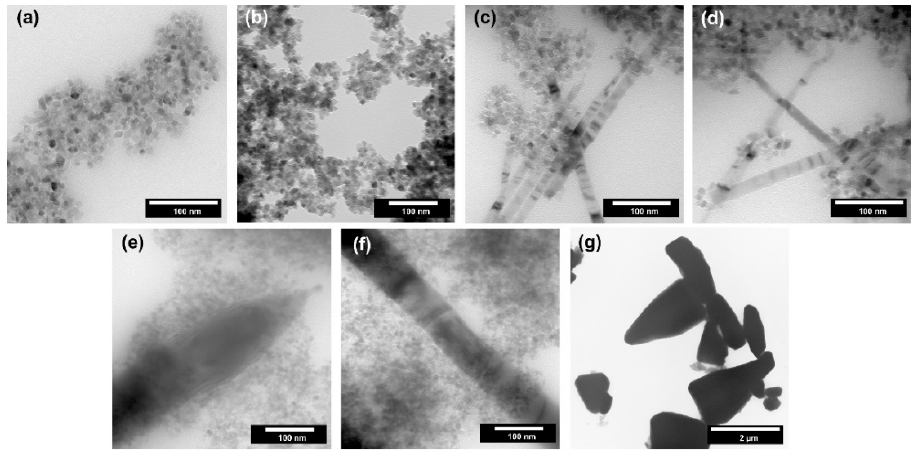
Figure 6. The TEM images for TiO 2 -ZnO systems and reference samples: ( a ) TiO 2 ; ( b ) TiO 2 - (2.5%)ZnO; ( c ) TiO 2 -(5%)ZnO; ( d ) TiO 2 -(10%)ZnO; ( e ) TiO 2 -(15%)ZnO; ( f ) TiO 2 -(20%)ZnO and ( f ) ZnO.